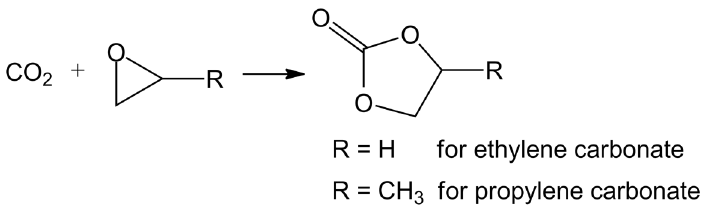
Figure 25. Synthesis of ethylene carbonate through reaction between CO 2 and ethylene oxide. Reproduced with permission from Martina Peters, Burkhard Kohler, Wilhelm Kuckshinrichs, Walter Leitner, Peter Markewitz, Thomas E. Muller, ChemSusChem; published by John Wiley and Sons, 2011